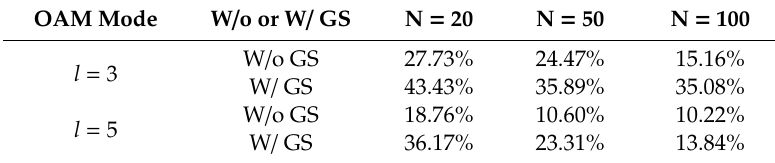
Table 3. The PD values of OAM beams without (W/o) and with (W) GS algorithm corresponding to Figure 5.